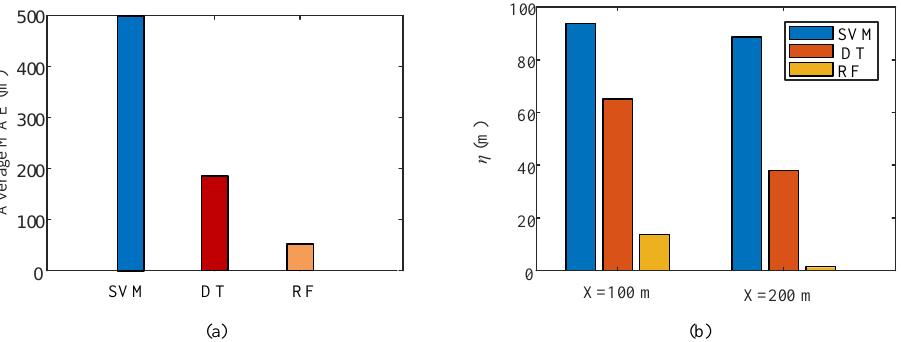
Figure 5. Performance comparison of SVM, DT and RF ML algorithms: ( a ) Average MAE, and ( b ) value of η with prediction error > X m. The y -axis in Figure 5a is limited to 500 m for better visualization of the